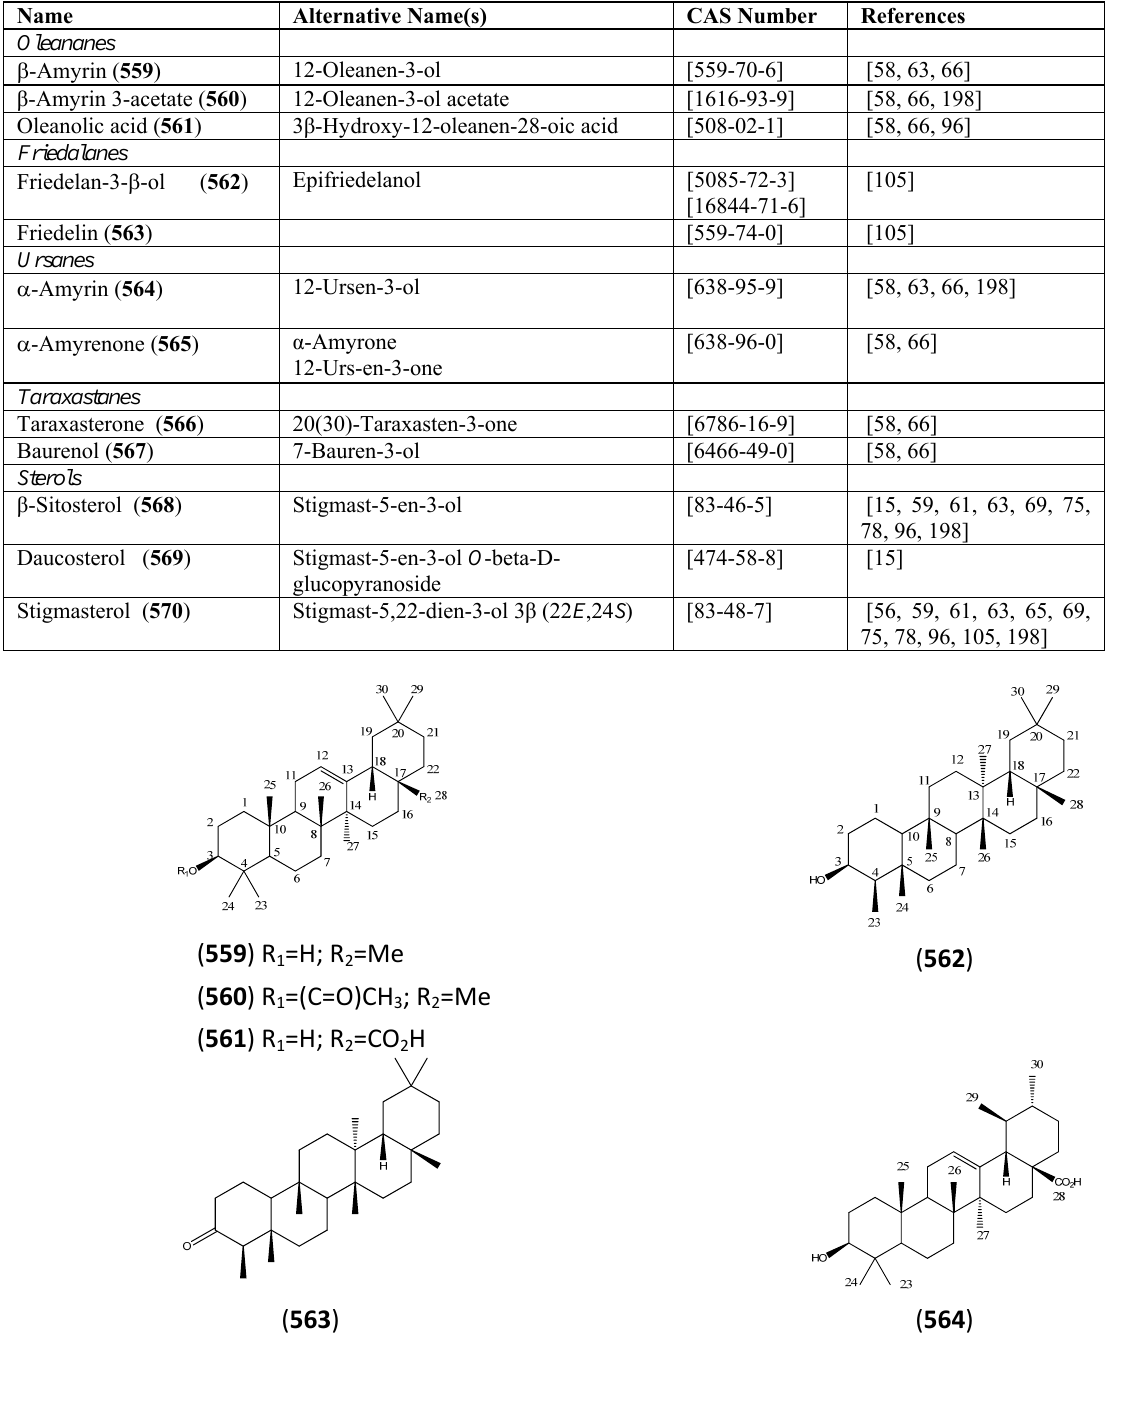
Table 43. Triterpenoids and